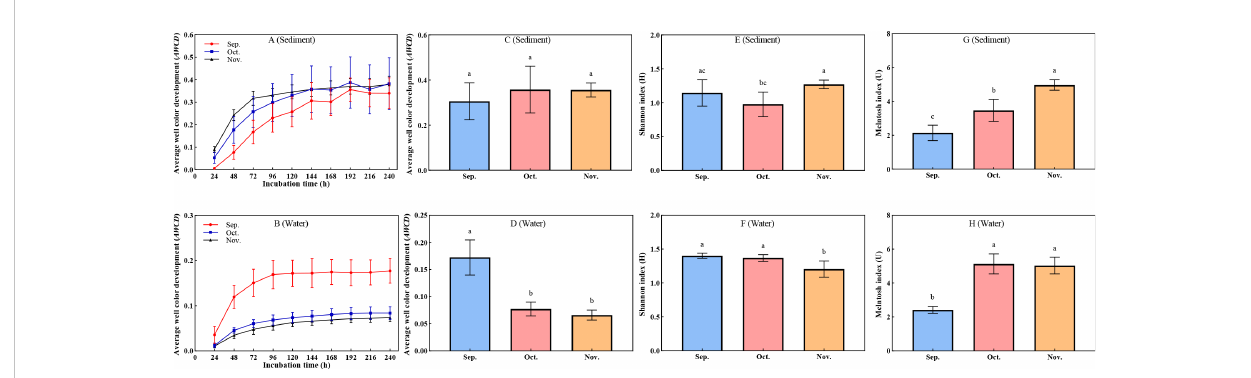
FIGURE 1 Metabolic characteristics and functional diversity in water and sediment. (A – D) Changes in average well color development (AWCD). (E , F) Changes in Shannon index (H) . (G , H) Changes in McIntosh index (u). The superscripts without same letter in the same row indicate signi fi cant difference ( P